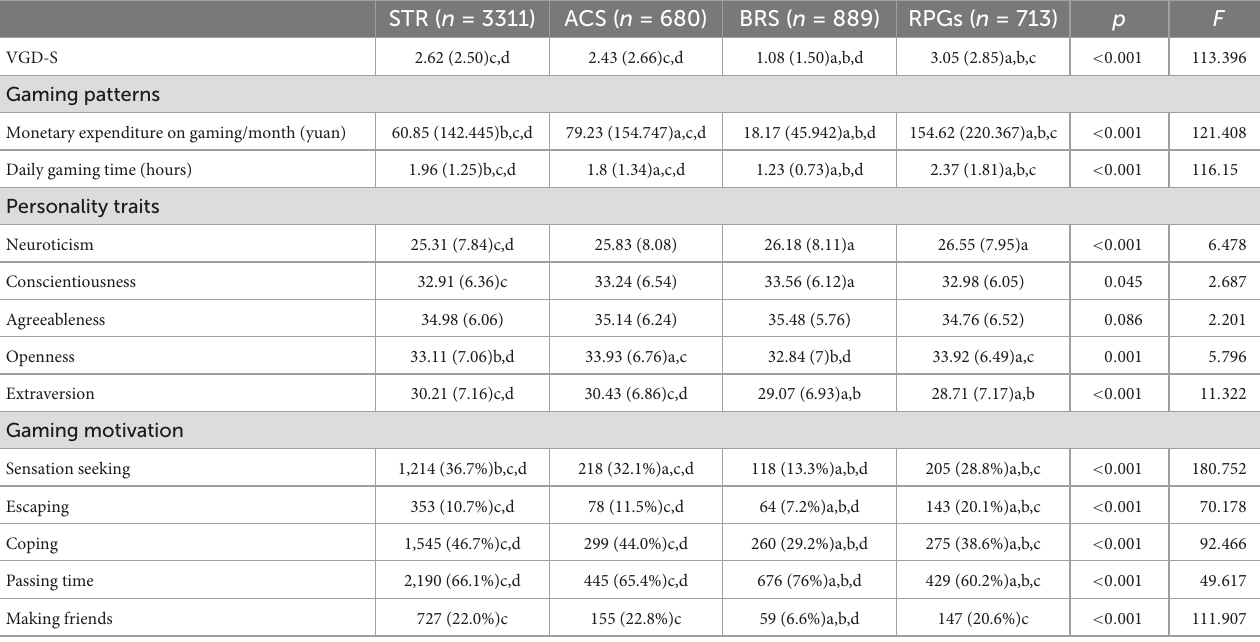
TABLE 2 Within-group comparisons of video game dependency scale scores, gaming patterns, personality traits, and gaming